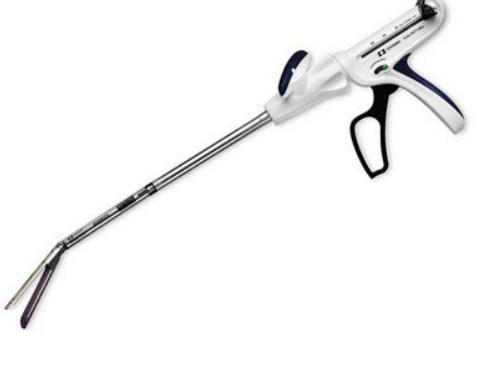
Fig.1. Medtronic’s Endo GIA laparoscopic